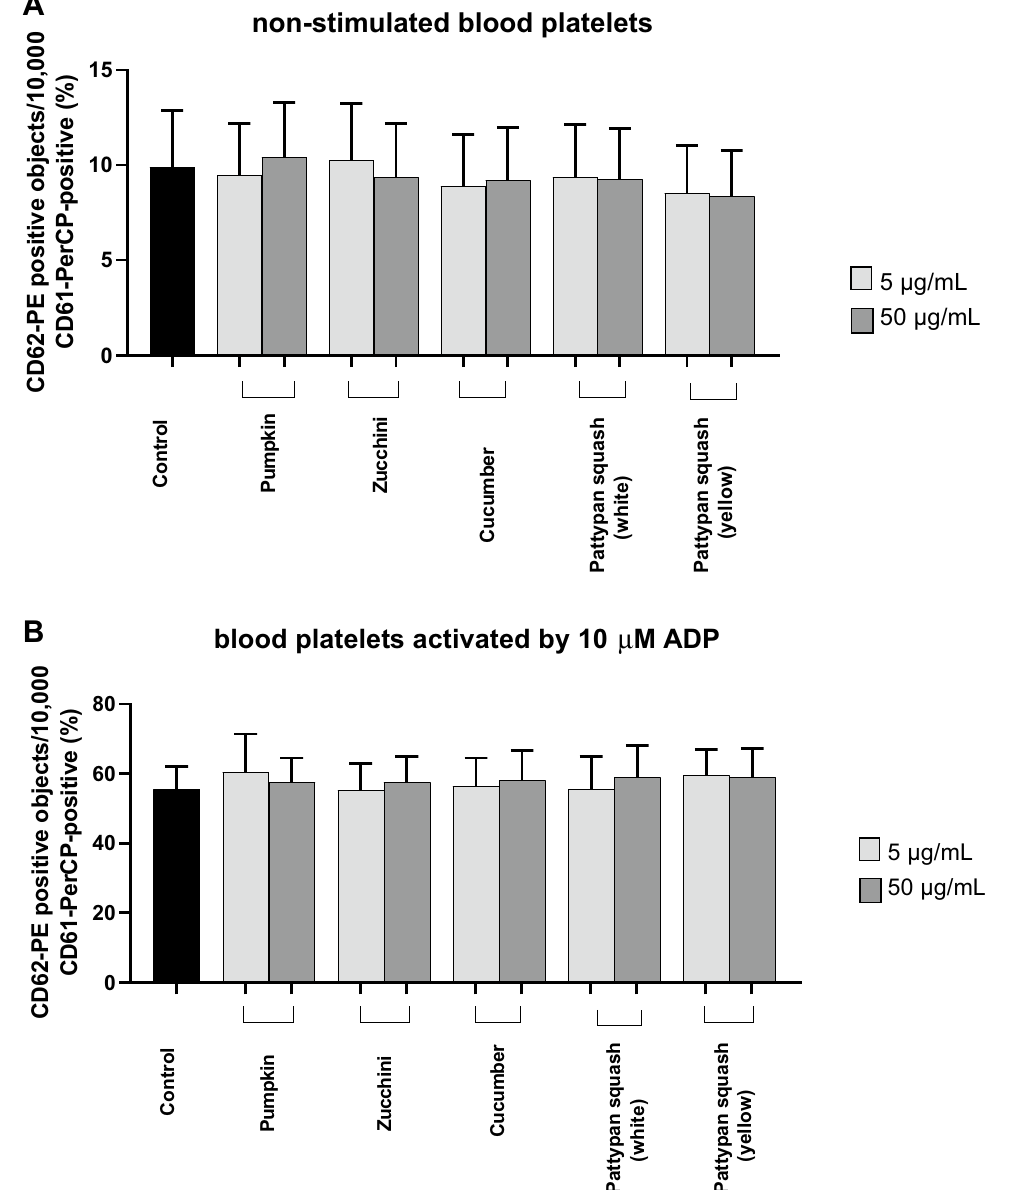
Figure 6. Effects of the five cucurbit vegetable preparations (concentrations 5 and 50 µg/mL, incubation time— 30 min) on expression of P-selectin on resting ( A ) or agonist-stimulated blood platelets: 10 µM ADP ( B ), 20 µM ADP ( C ) and 10 µg/mL collagen ( D ) in whole blood samples. The blood platelets were distinguished based on the expression of CD61/PerCP. For each sample, 5000 CD61-positive objects (blood platelets) were acquired. For the assessment of P-selectin expression, samples were labeled with fluorescently conjugated monoclonal antibody CD62P. Results are shown as the percentage of platelets expressing CD62P. Results are given as the mean ± SD of six healthy volunteers (each experiment performed in triplicate). There wasn’t any statistically significant between effect of 5 and 50 µg/mL (p >